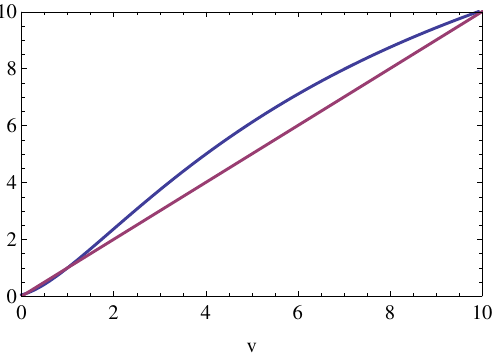
Figure 5. (Color online) The graph of the function f θ , ϕ for θ = 0.2, ϕ =